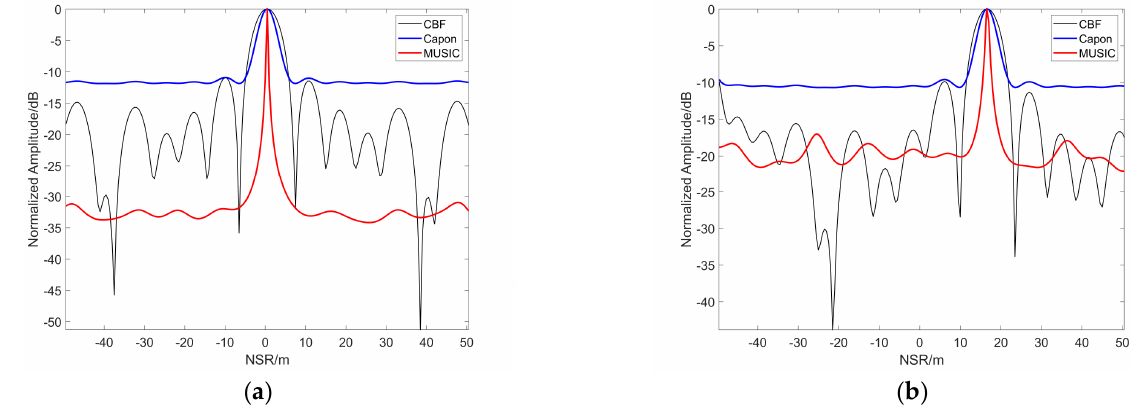
Figure 24. Moving point result ( v x = 2 m/s) with baseline number 10: ( a ) 1st point; ( b ) 55th point.